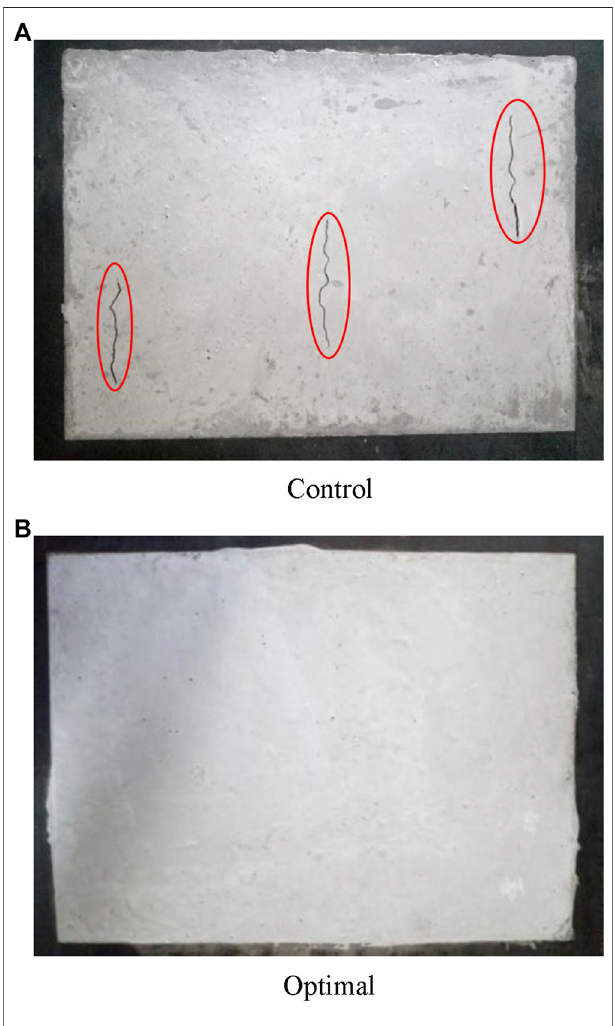
FIGURE 6 | Cracking states of control and optimal at the age of 3 days. (A) Control; (B) Optimal.